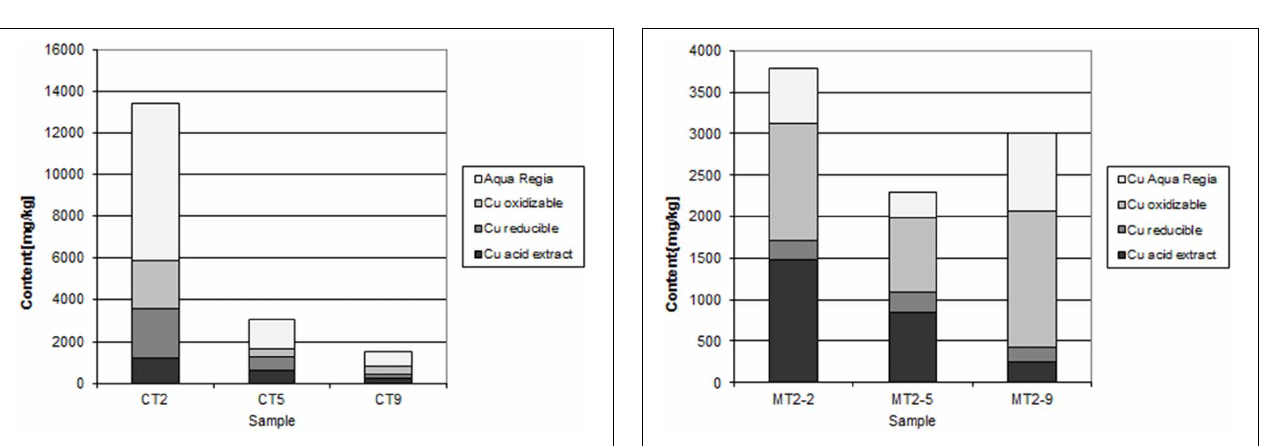
FIGURE 7 | Sequential extraction of Chambishi samples: Cu.